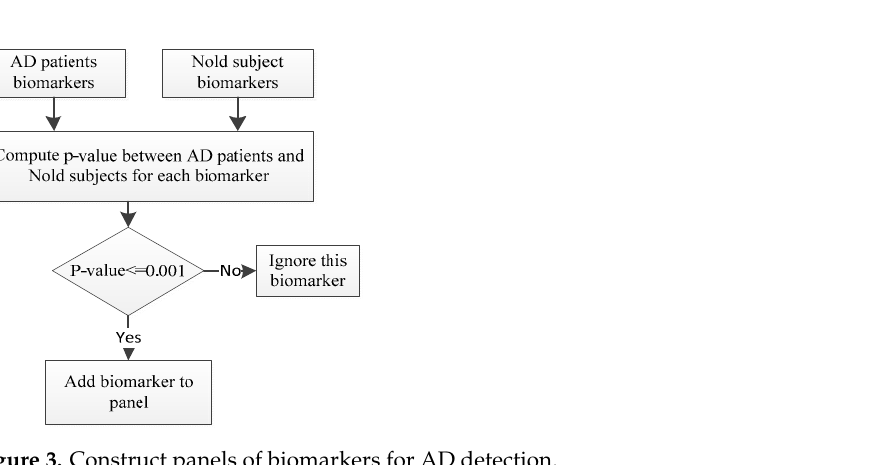
Figure 3. Construct panels of biomarkers for AD detection.